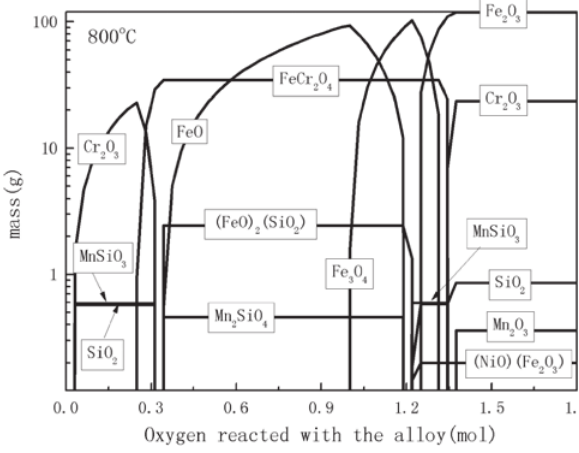
Fig. 1: Equilibrium of oxygen to 100 g Fe-16Cr alloy at 800 °C.